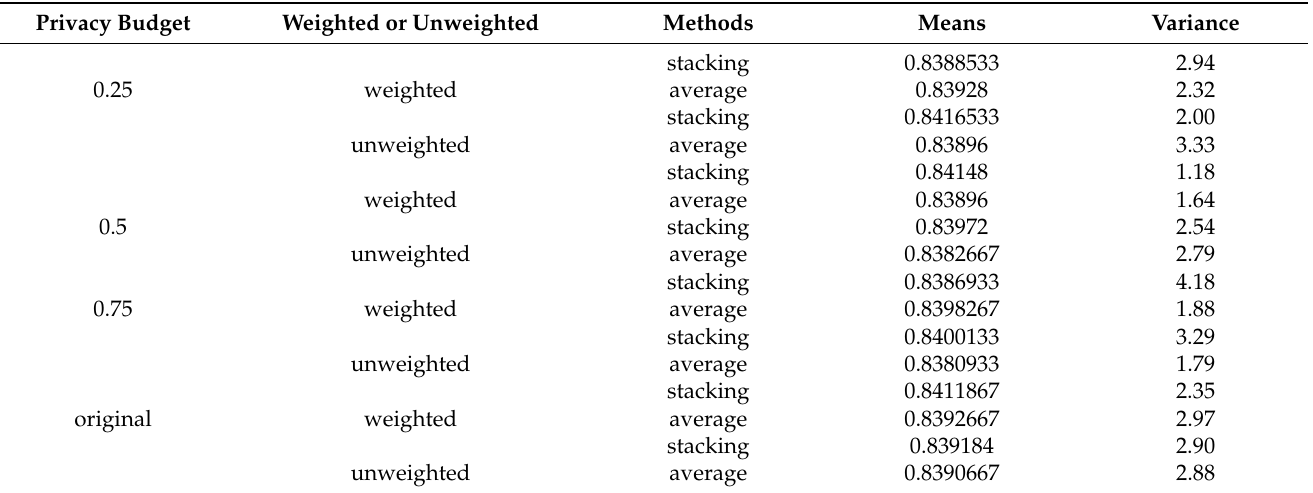
Table 8. The t 3 time section uses different methods to calculate the change table of the updated global model h 3